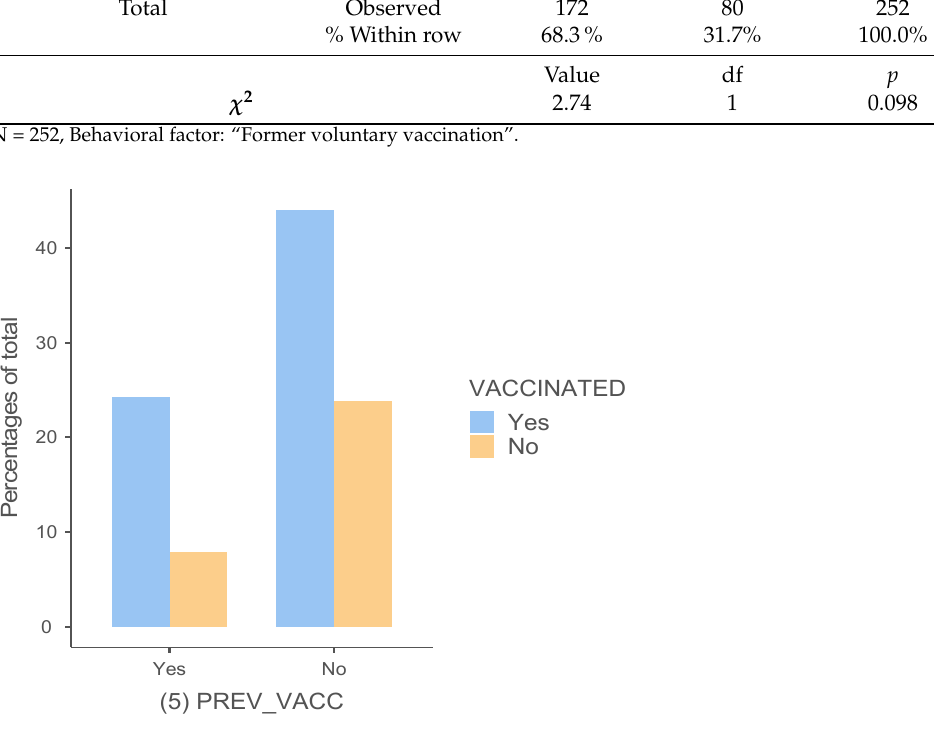
Figure 3. Previous voluntary vaccination and decision to vaccinate against COVID-19. The horizontal axis: groups of previously vaccinated/not vaccinated; the vertical axis: percentage of vaccinated against COVID-19.